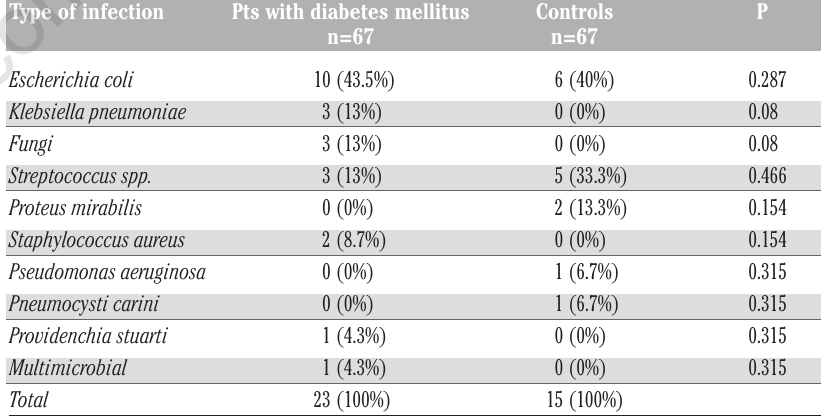
Table 3. Microorganisms isolated from diabetic patients and controls.